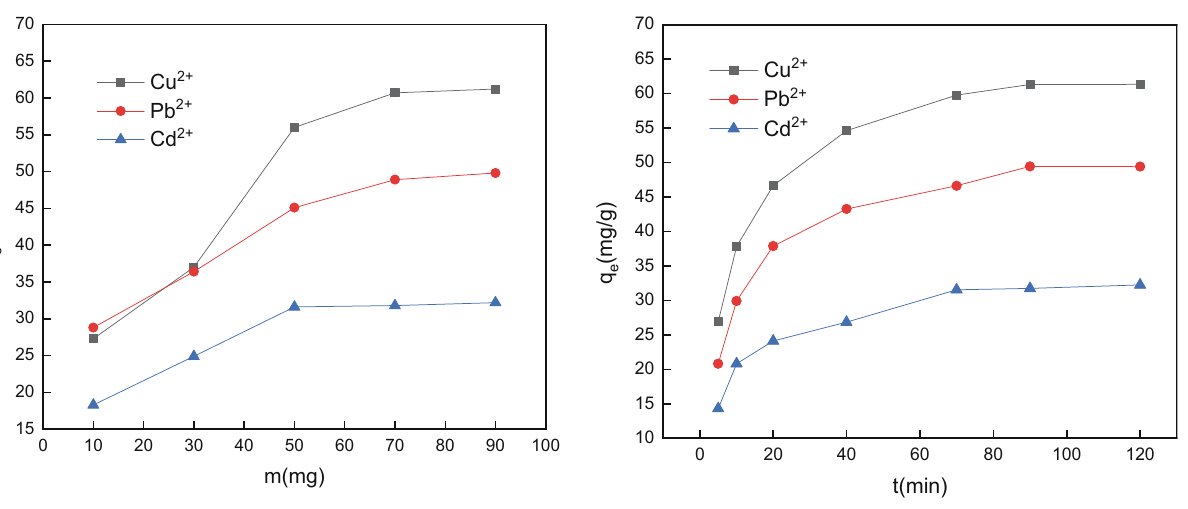
Figure 5: E ff ect of adsorption time on the adsorption of Cu 2 + , Pb 2 + , and Cd 2 + by